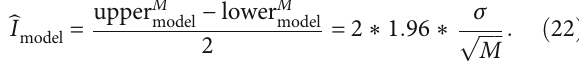
Table 3: MSFT put option traded on 19/03/2021 at a price of S